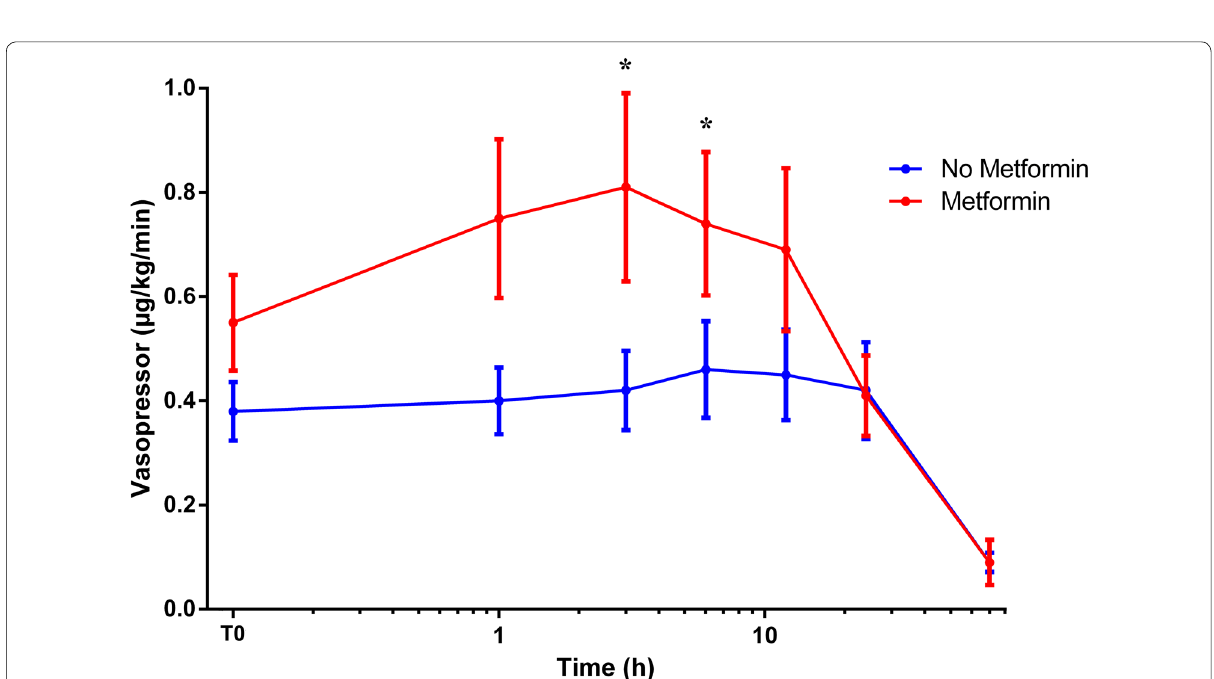
Fig. 2 Initial evolution of vasopressor dosage in ICU diabetics sustaining septic shock with or without pre‑admission metformin treatment. T0: time of septic shock diagnosis. Abscissa axis is log 10 scale. * p <